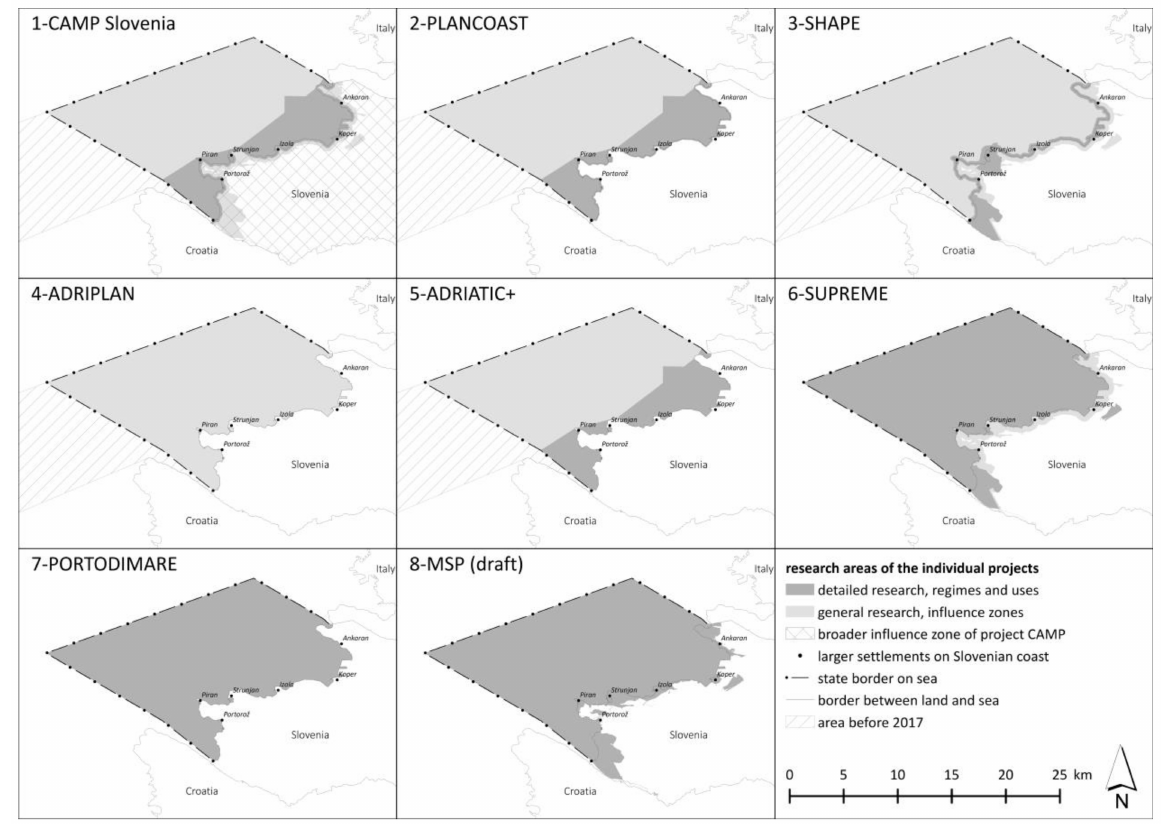
Figure 1. Project application areas; synthetic presentation of particular